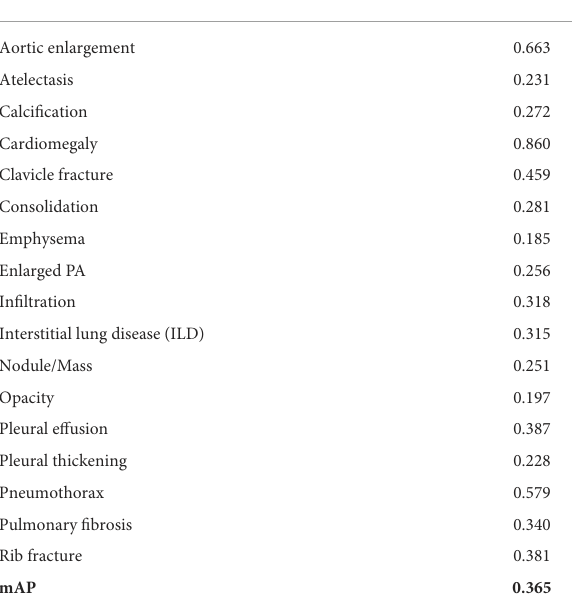
TABLE 1 Performance of the lesion detector on 17 classes of